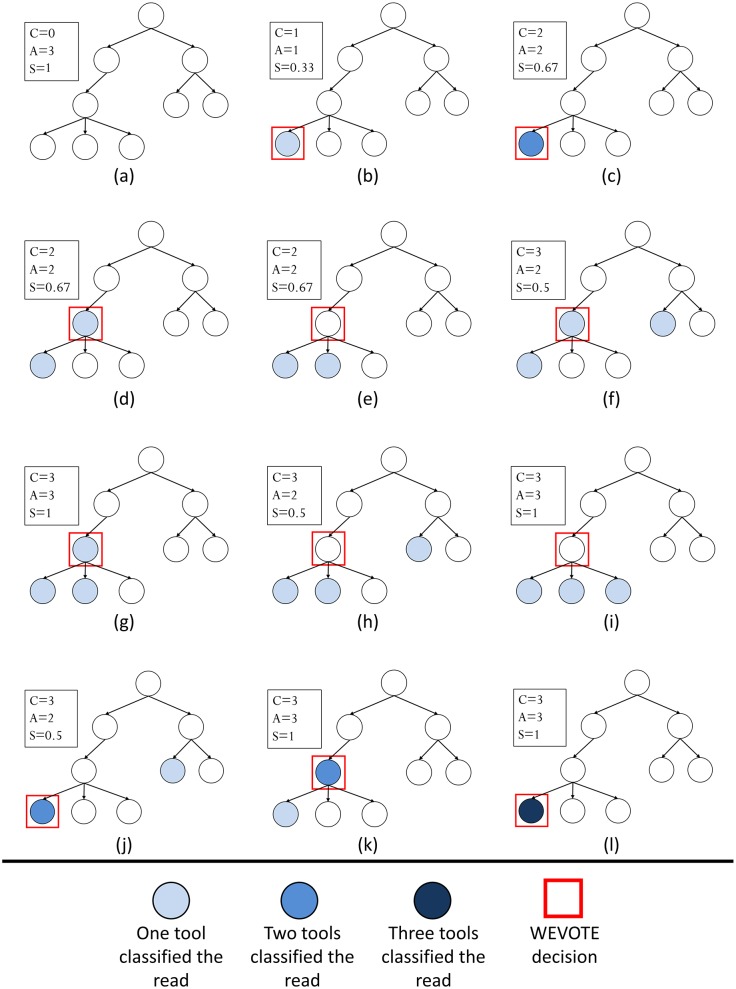
WEVOTE case scenarios using three tools. C denotes the # tools able to classify the read, A represents the # of tools that support WEVOTE Decision, and S represents the WEVOTE score.Scenarios are shown for (a) None of the three tools classified the read; (b) Only one tool classified the read; (c) Two tools classified the read with the same taxon; (d, e) Two tools classified the read with two different taxa; (f-i) Three tools classified the read with three different taxa; (j, k) Three tools classified the read, two taxa are identical, and the other is different; (l) Three tools identified the read with the same taxon.